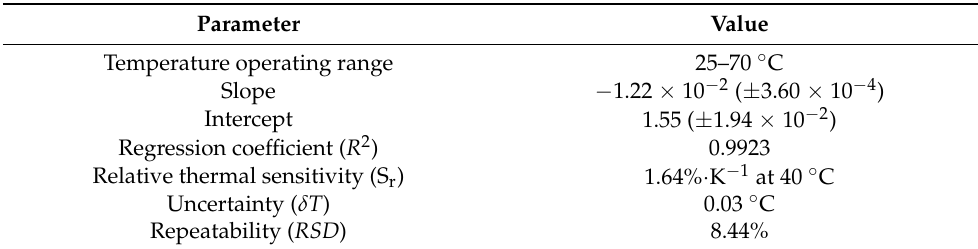
Table 1. Calibration parameters of the thermometer IONP@SiO 2 - acac /Tb 3+ /Eu 3+ . Parameter Value Temperature operating